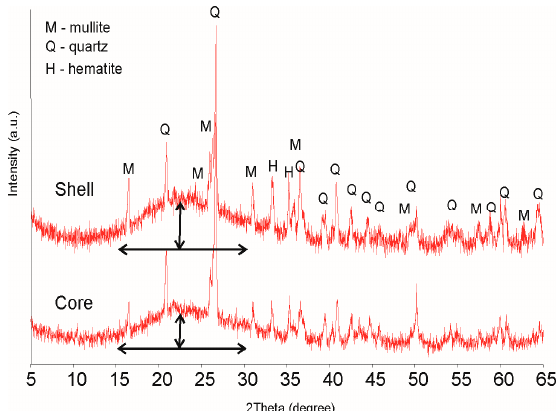
Figure 2. XRD patterns of internal (core) and external (shell) zones of lightweight aggregates (LWAs) (S + NAP 8%). Arrows show the height of the spectra from the basic line within a 2 θ range of 15°–30°.